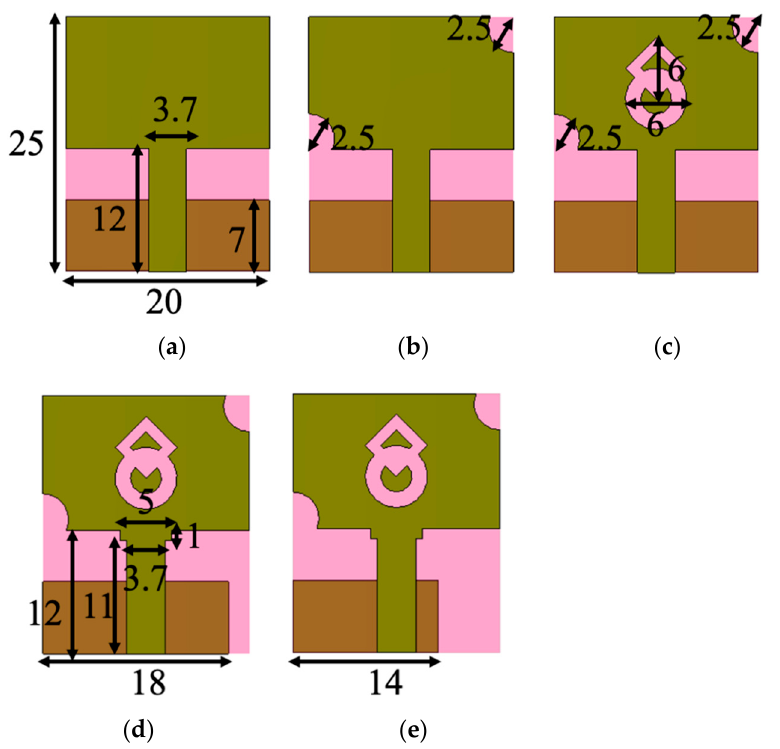
Figure 2. Evolution stages of the proposed antenna. ( a ) Evolution-1, ( b ) Evolution-2, ( c ) Evolution-3, ( d ) Evolution-4, and ( e ) Evolution-5.